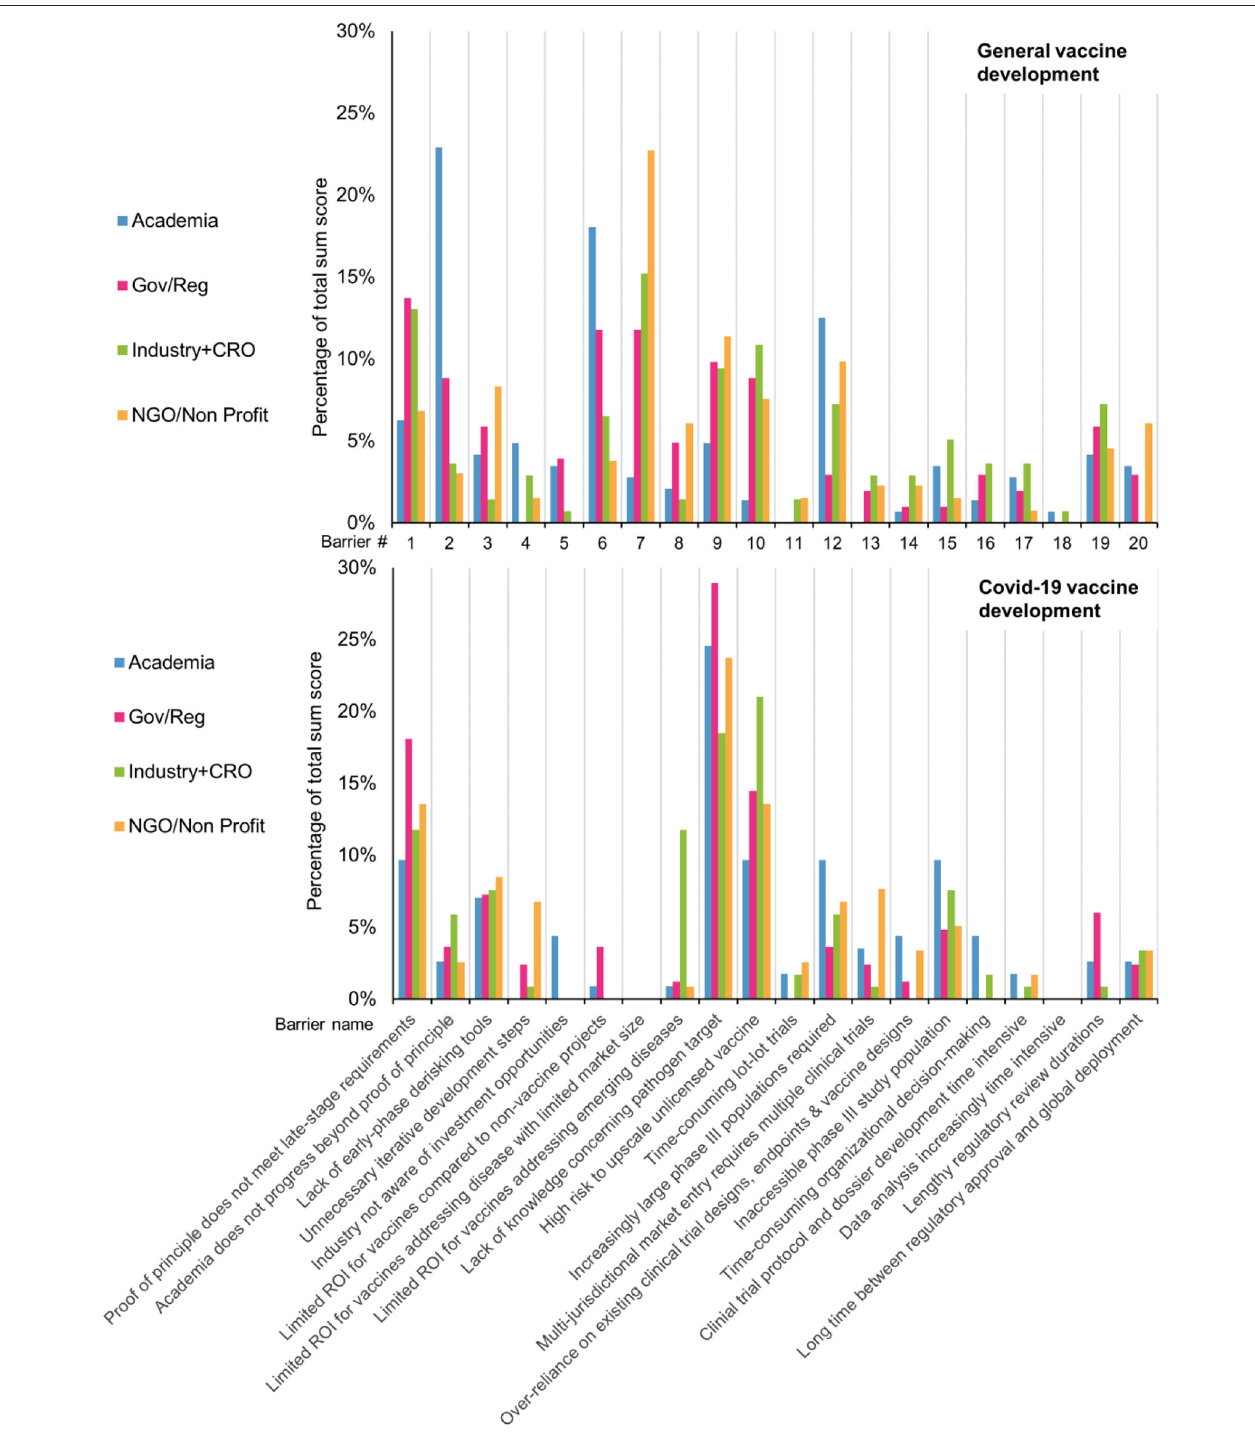
FIGURE 7 | During general development, KOLs from different work areas ranked the impact of each barrier on development timelines differently. In contrast, during Covid-19, the different groups largely agreed on the impact of each barrier.